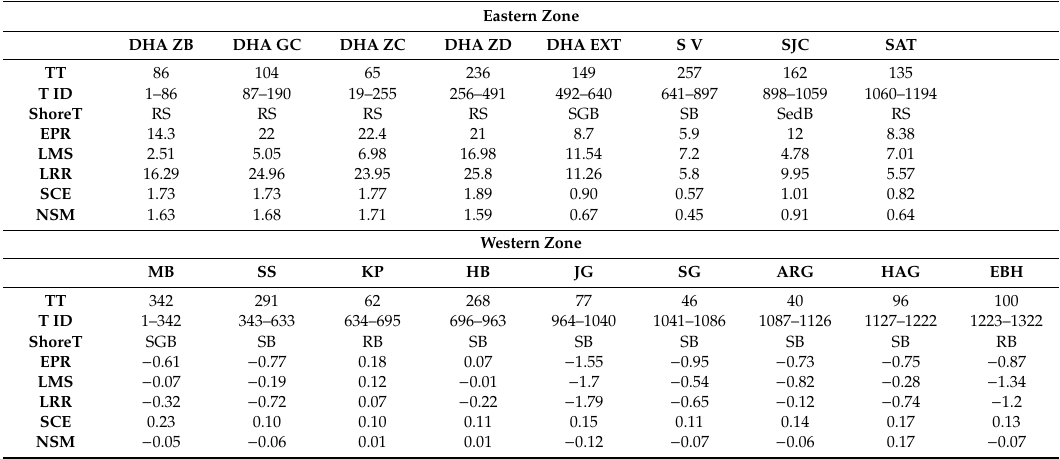
Table 1. Average shoreline change rate of the eastern and western zone. Eastern